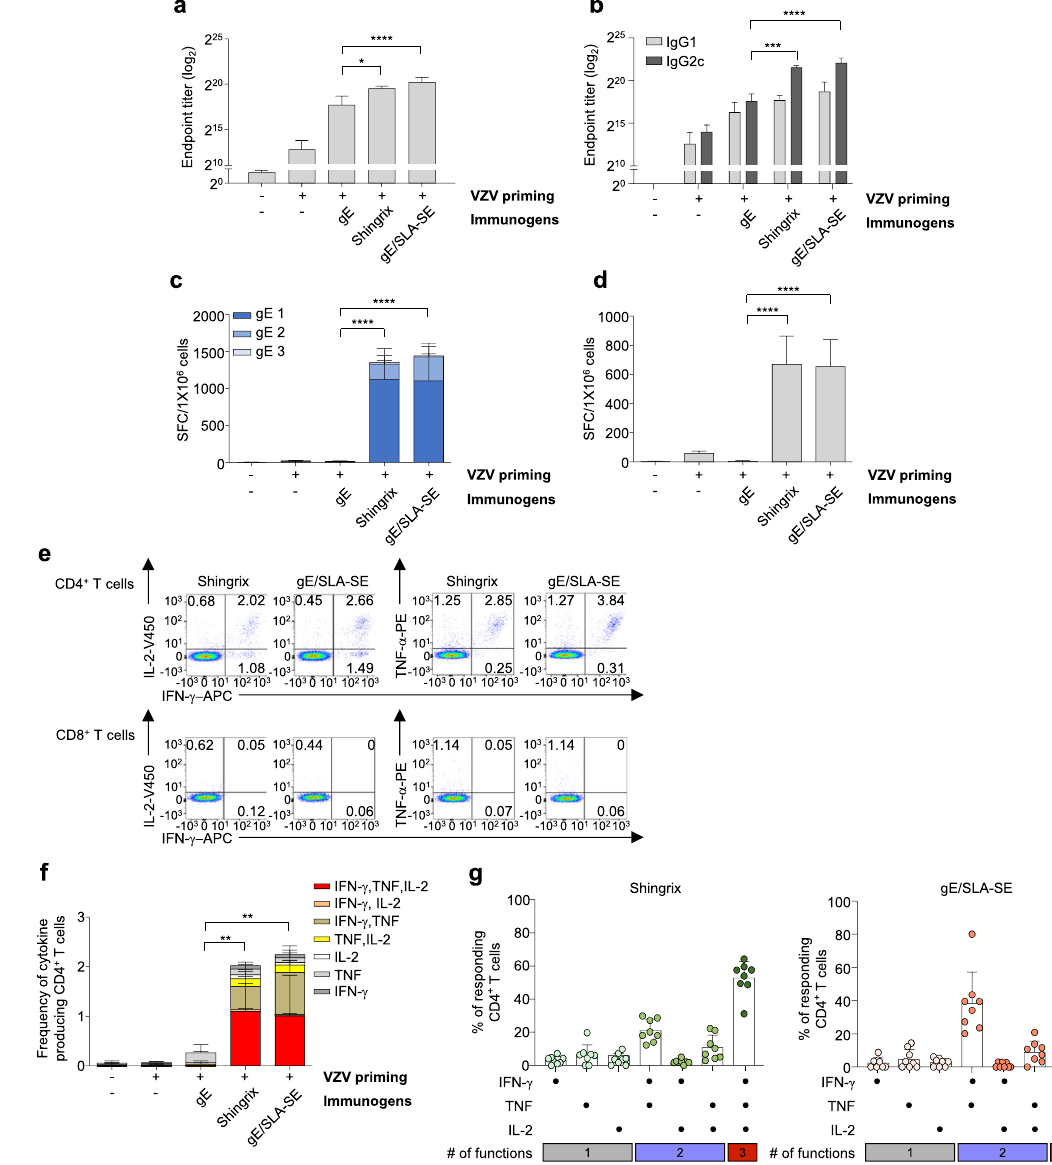
Fig. 2 Comparison of gE- or VZV-speci fi c immune responses of gE/SLA-SE with Shingrix in young mice. Six-week-old C57BL/6 mice were primed with live attenuated VZV, and then immunized twice with gE (5 µg), gE (5 µg)/SLA-SE (10 µg SLA in 2% oil), or Shingrix (1/10 of human dose, gE [5 µg]/AS01 B [5 µg MPL and 5 µg QS21]) at a 4-week interval. Four weeks after the second immunization, serum was obtained from immunized mice to examine humoral immunity and spleen cells prepared to examine cell-mediated immunity. a gE-speci fi c total IgG endpoint antibody titer (log 2 transformed) using serum from immunized mice. b gE-speci fi c IgG1 and IgG2c antibody titer (log 2 transformed) using serum from immunized mice. c , d IFN- γ -producing T-cell populations by mouse IFN- γ ELISPOT assay using spleen cells from immunized mice upon antigenic stimulation with ( c ) three pools of 62 gE OLPs (15-mer, 5-mer overlap): gE 1 (20 peptides), gE 2 (20 peptides), and gE 3 (22 peptides) or ( d ) VZV-infected cell lysate. e Representative FACS plots of cytokine-secreting CD4 + and CD8 + T-cell populations in Shingrix or gE/SLA-SE immunized mice upon gE OLP stimulation. f Measurement of the frequency of cytokine-producing CD4 + T cells for IFN- γ , TNF, and IL-2 upon gE OLP stimulation. g CD4 + T-cell polyfunctionality analyzed by every possible combination of functions using Boolean analyses in spleen cells from either Shingrix immunized mice or gE/SLA-SE immunized mice upon gE OLP stimulation. Data are representative of two independent experiments, and data are presented as means and standard deviations. * P < 0.05, ** P < 0.01, **** P < 0.001 (ordinary one-way ANOVA). n = 4 (control), 8 mice per